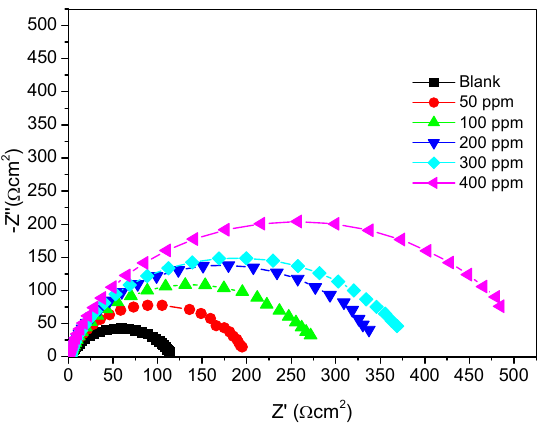
Figure 3. Nyquist plots for mild steel corrosion in 1 M HCl with and without different concentrations of